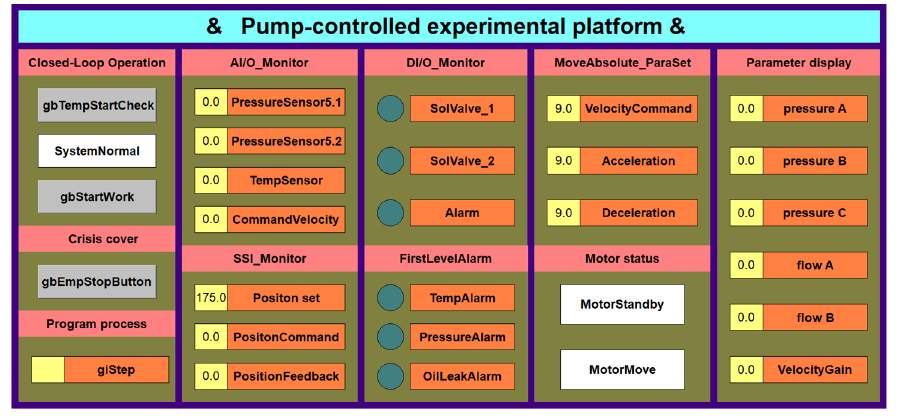
Figure 6. Pump control experiment platform.